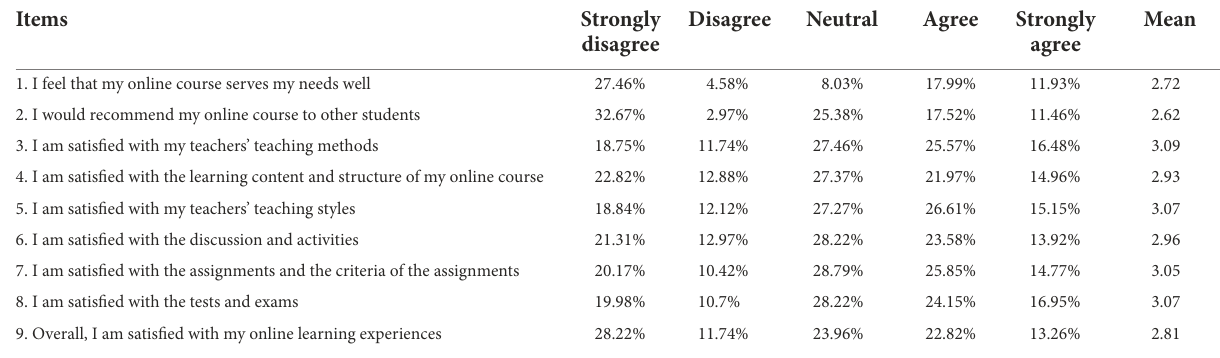
TABLE 6 Means of online learning